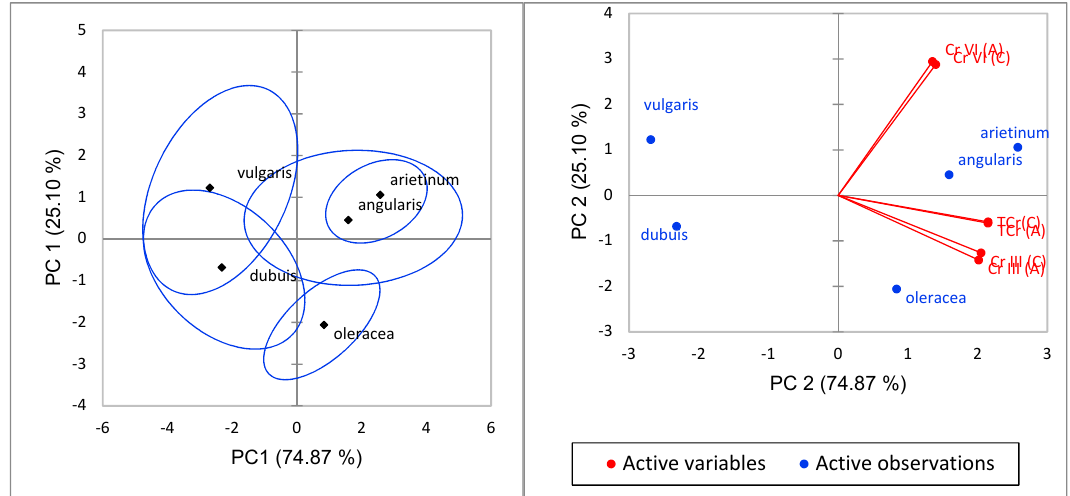
Figure 4. Principal component analysis (PCA) plot of the relationship between the sampled plants species ( vulgaris, dubuis, oleracea , angularis and arietinum ) and the relationship between concentration of Ch T , Cr(VI) and Cr(III) (active variables) in the stems (A) and leaves (C) of the edible vegetables (active observations) for the first two principal components obtained (PC1 and PC2).